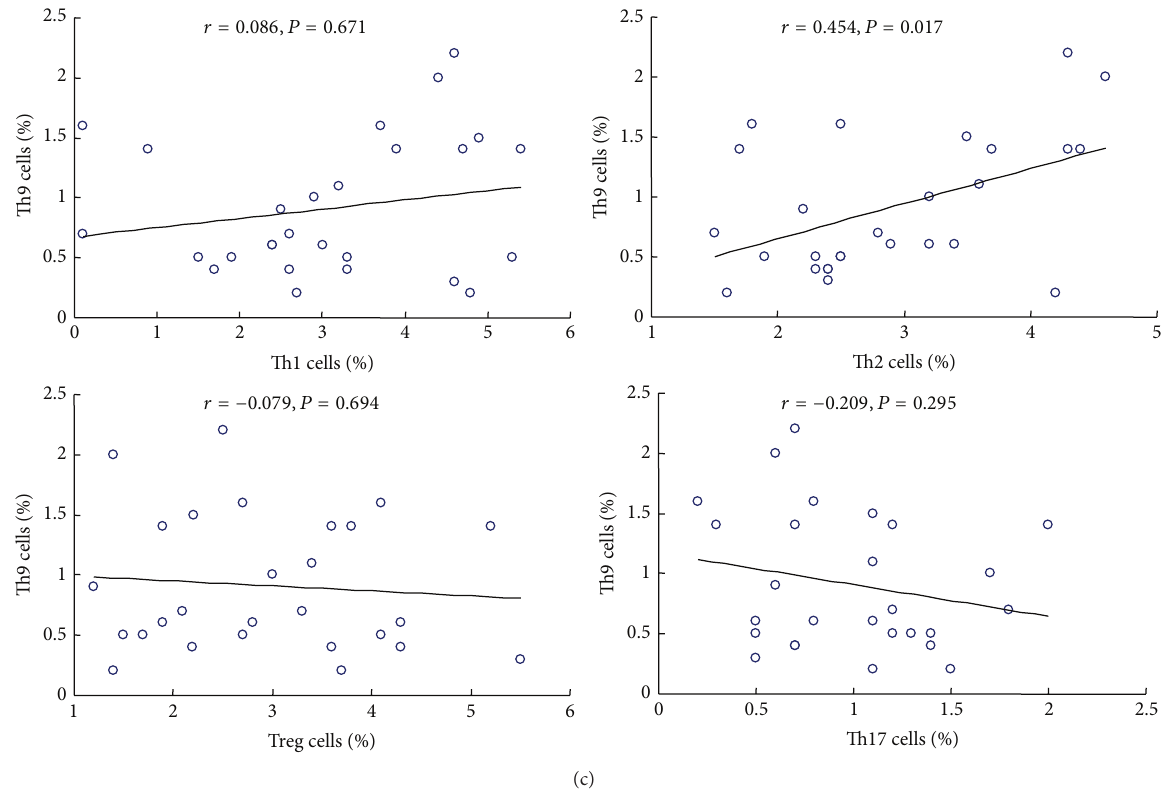
Figure2:PercentagesofTh9,Th1,Th2,Th17,andTregscellsinperipheralblood.SubtypesofCD4 + Tcellsinperipheralbloodweredetectedby flow cytometry analysis. The detected cell types included Th9 (IL-9 + ) cells, Th1 (IFN- 𝛾 + ) cells, Th2 (IL-4 + ) cells, Treg (Foxp3 + ) cells, and Th17 (IL-17 + ) cells. Cells were first gated on CD3 + CD4 + T cells and then on IL-9 + /IFN- 𝛾 + /IL-4 + /Foxp3 + /IL-17 + CD3 + CD4 + T cells, respectively. (a) The representative flow cytometric dot-plots of Th9, Th1, Th2, Th17, and Tregs cells in the blood of the HC, CE, and PCE groups were shown. Numbers within each quadrant indicated percentages of cells within each dot-plot. (b) Comparisons of the percentages of Th9, Th1, Th2, Th17, and Tregs cells in the peripheral blood of the HC, CE, and PCE groups. Horizontal bars indicated means. The percentages of Th cells represented Th cell numbers in total CD4 + T-cell numbers were determined by flow cytometry. (c) Th9 cells were correlated negatively with Th1, Th17, and Tregs cells, while Th9 cells were positively correlated with the numbers of Th2 in peripheral blood in CE patients. Correlations were determined by Spearman rank correlation coefficients. HC: healthy control; CE: CE pretherapy group; PCE: CE post-therapy group.